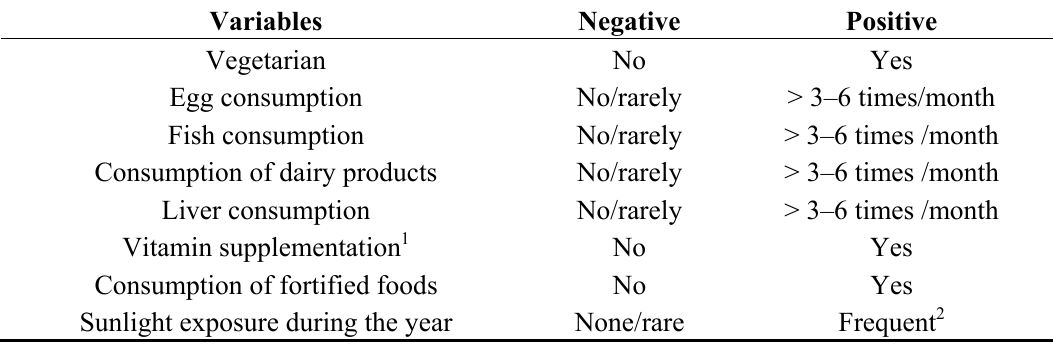
Table 2. Information Collected through